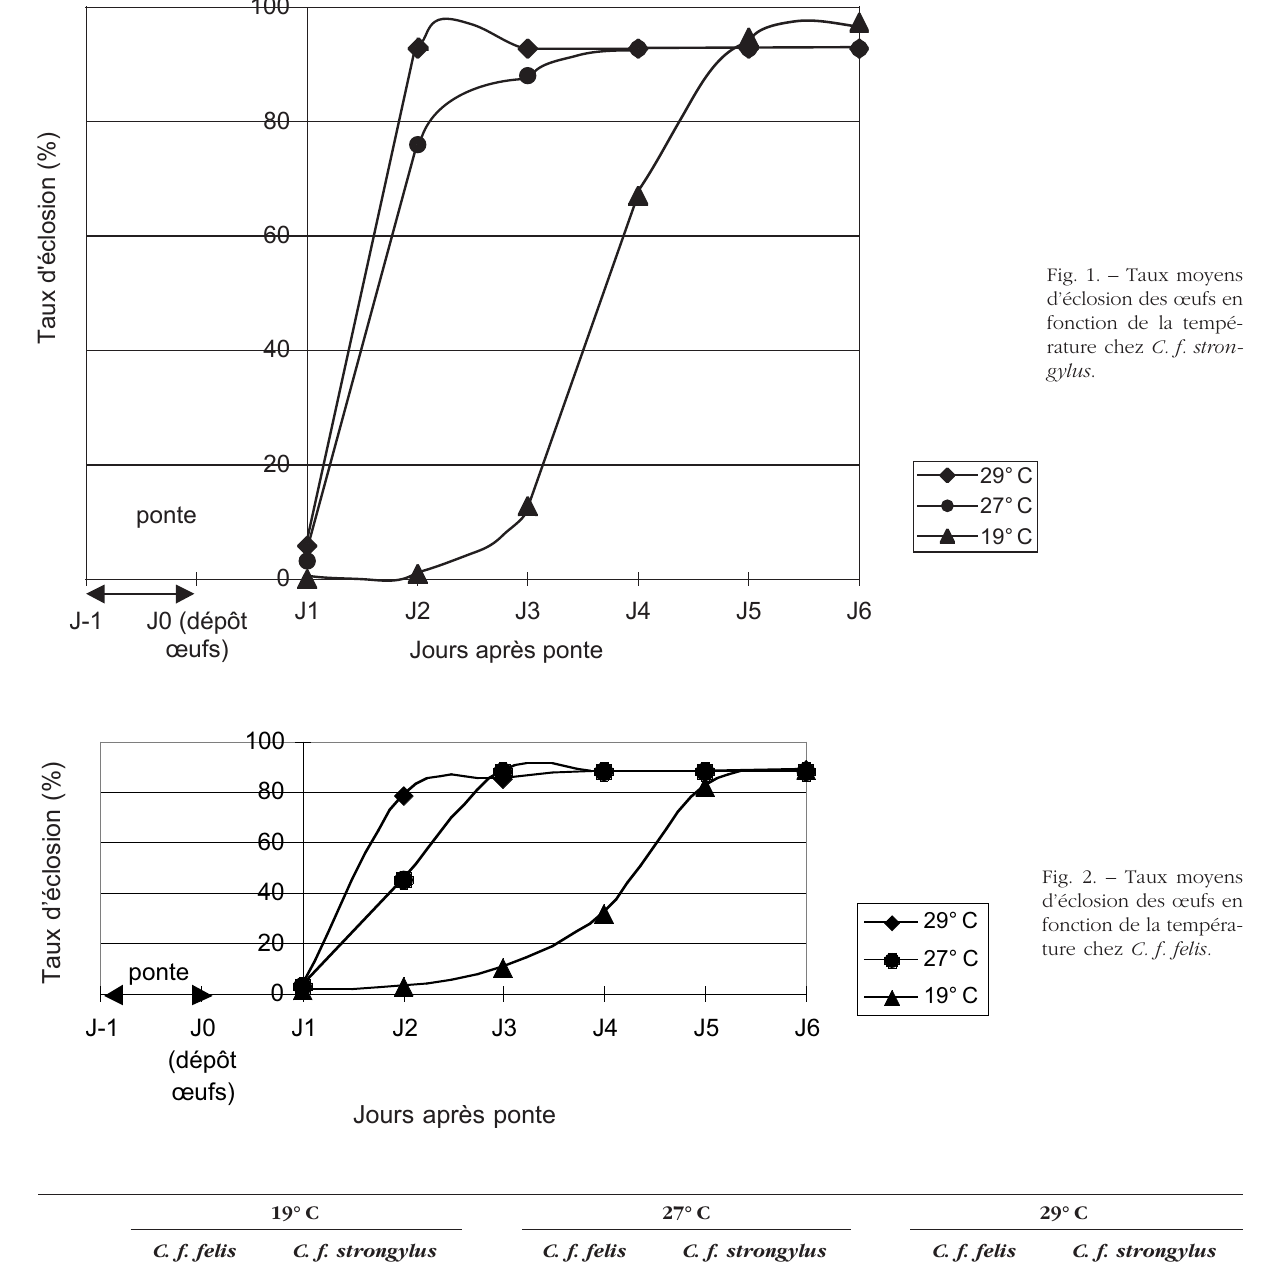
Fig. 1. – Taux moyens d’éclosion des œufs en fonction de la tempé- rature chez C. f. stron- gylus